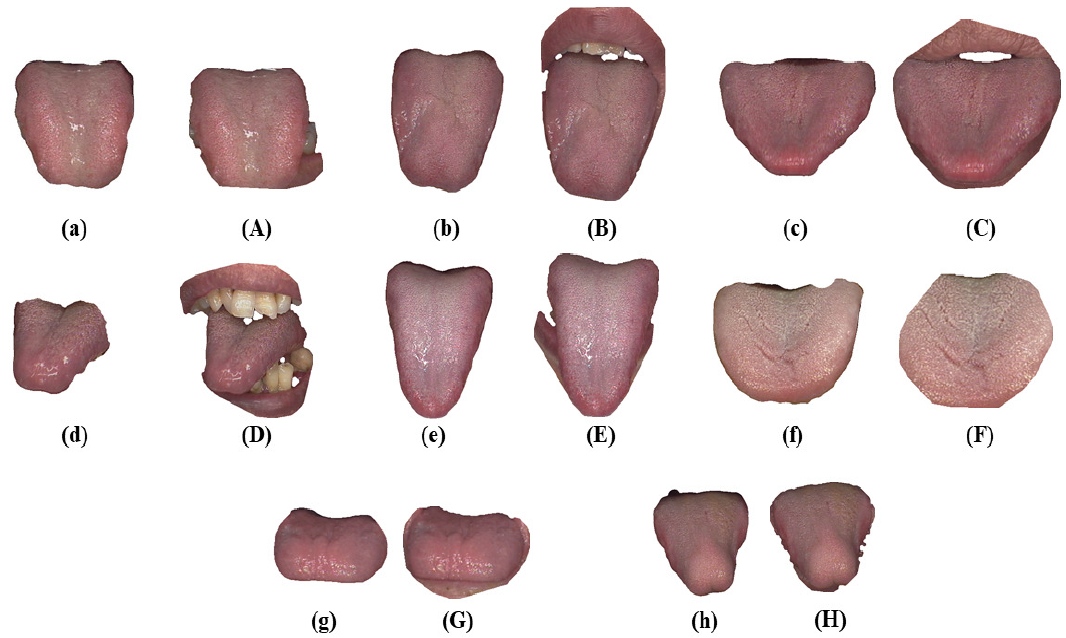
Figure 11. Comparison of a segmented tongue image from TongueNet (lowercase) and REF